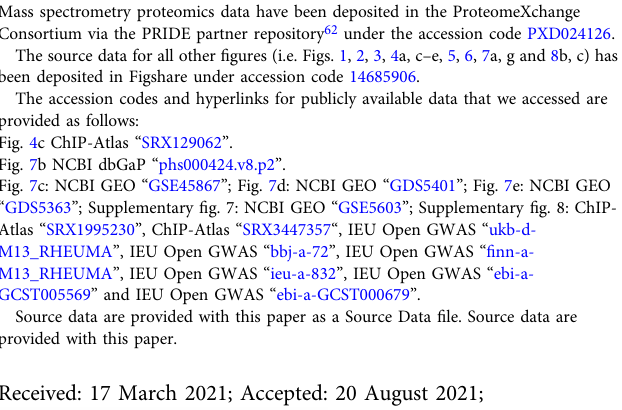
Fig. 4c ChIP-Atlas “ SRX129062 ” . Fig. 7b NCBI dbGaP “ phs000424.v8.p2 ” . Fig. 7c: NCBI GEO “ GSE45867 ” ; Fig. 7d: NCBI GEO “ GDS5401 ” ; Fig. 7e: NCBI GEO “ GDS5363 ” ; Supplementary fi g. 7: NCBI GEO “ GSE5603 ” ; Supplementary fi g. 8: ChIP- Atlas “ SRX1995230 ” , ChIP-Atlas “ SRX3447357 “ , IEU Open GWAS “ ukb-d- M13_RHEUMA ” , IEU Open GWAS “ bbj-a-72 ” , IEU Open GWAS “ fi